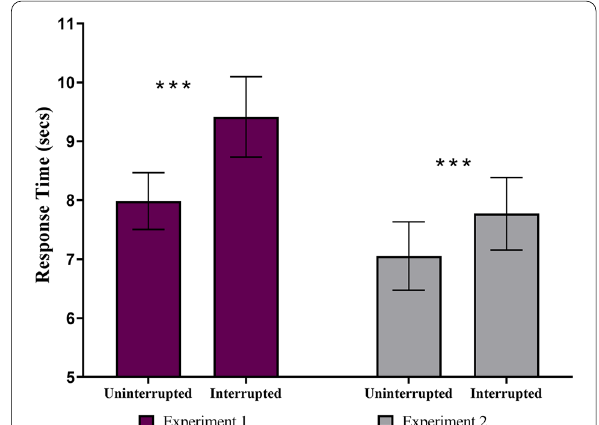
Fig. 3 We observed a significant interaction between trial-type (uninterrupted, interrupted) and search-type (Exp. 1: search for new targets, or Exp. 2: search repeatedly for the same target) on primary task accuracy. Accuracy was significantly lower during interrupted trials in Experiment 1 but not during Experiment 2. The stars denote significance (* p < .05, ** p < .01, *** p < .001). The error bars represent the standards error of the mean